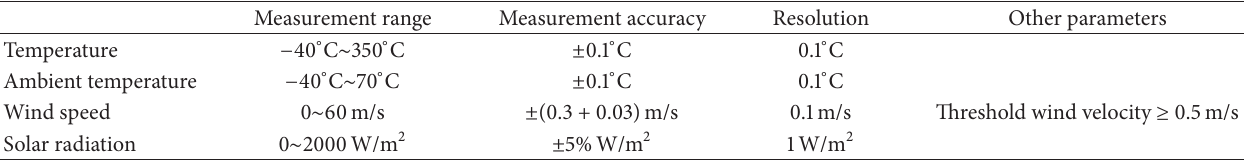
Table 3: Technical index of TRM-2 thermal performance testing system of solar water